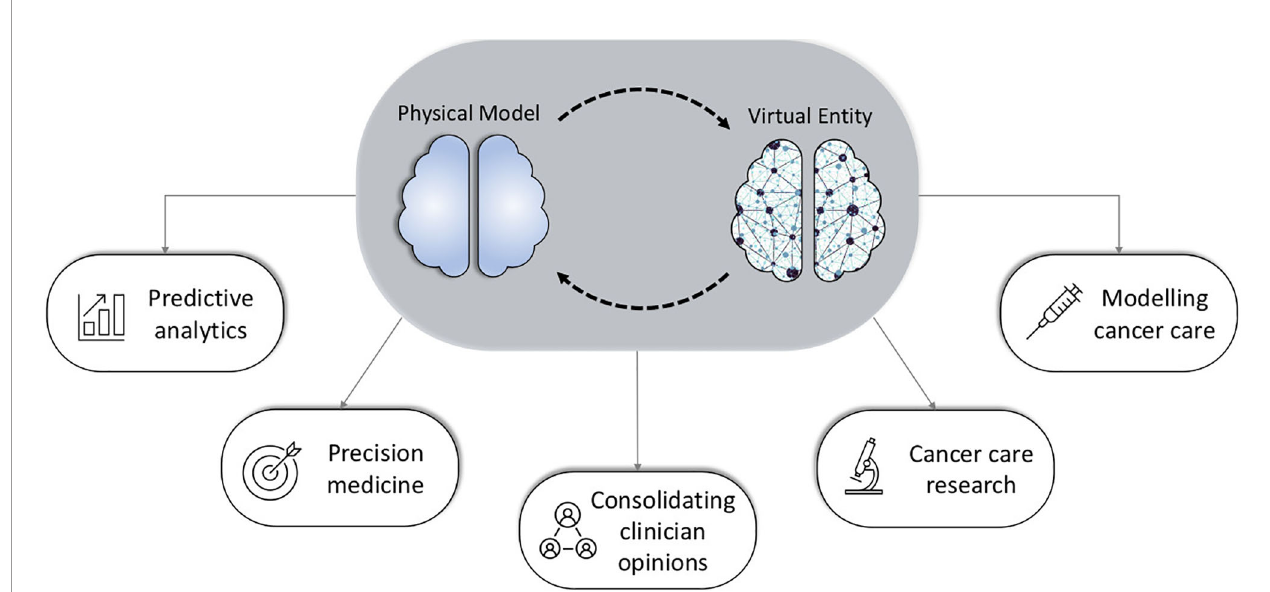
FIGURE 1 | An illustration of the digital twin concept and it ’ s proposed applications in pediatric cancer